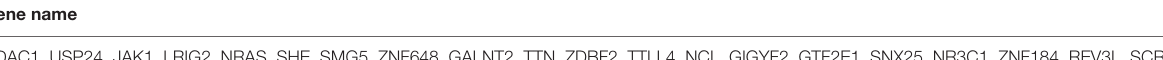
TABLE 3 | Forty-seven genes were significantly correlated with three selected m6A RNA methylation